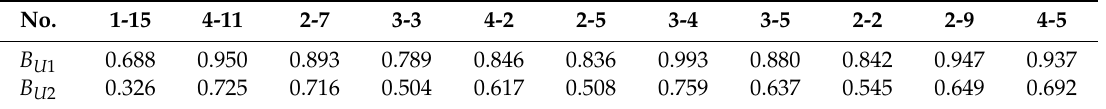
Table 7. Table of the brittleness indicator